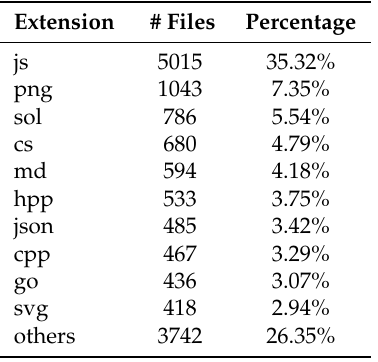
Table 2. The ten most common file extensions in Agile ICO